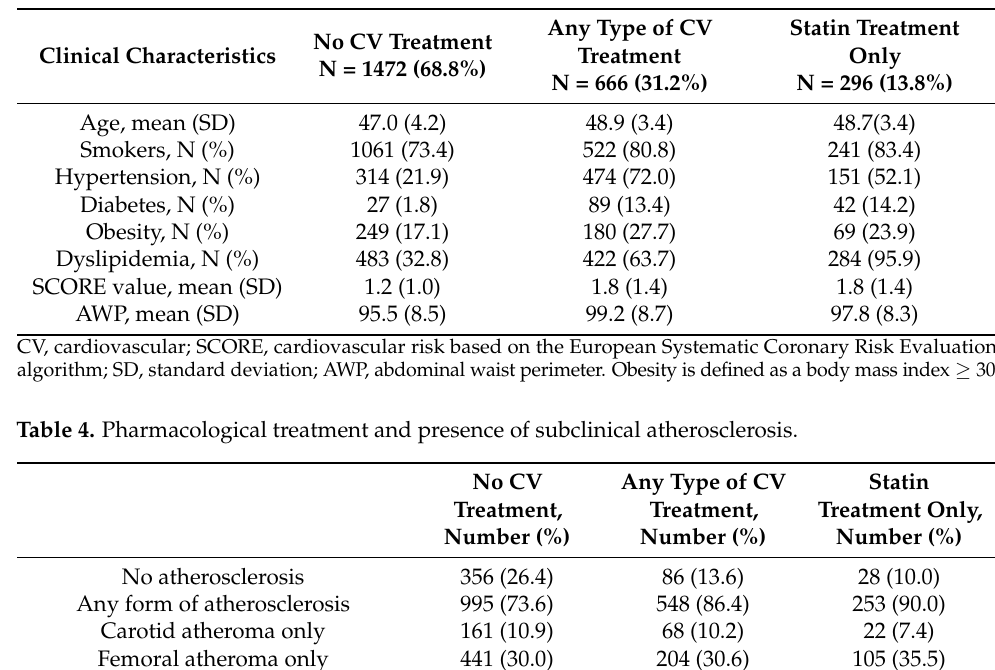
Table 3. Clinical characteristics according to pharmacological treatment status.